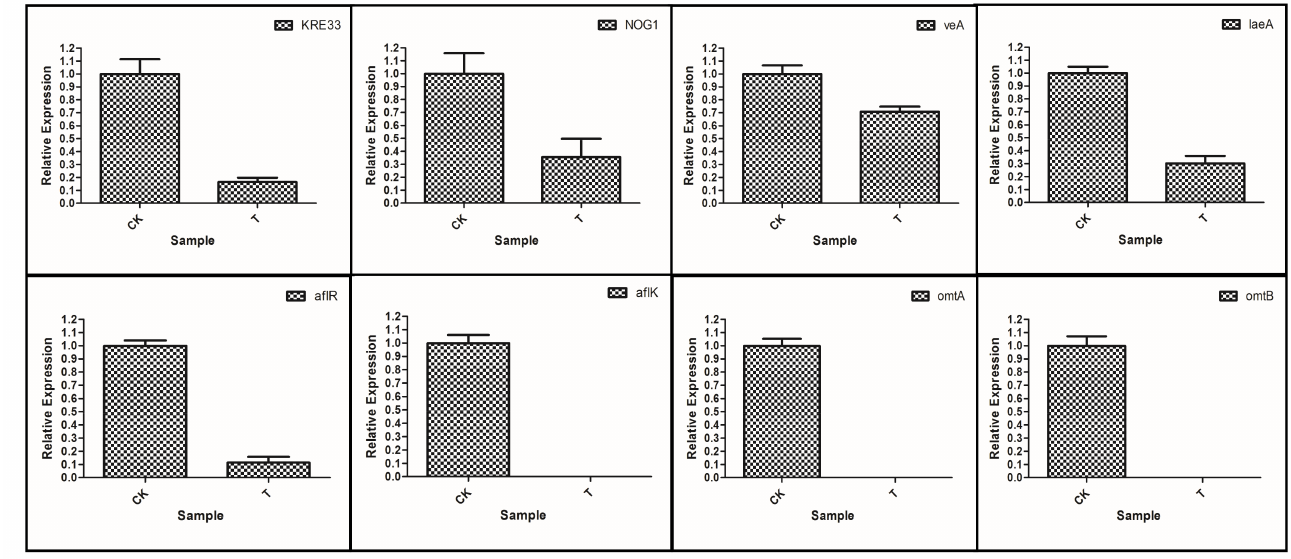
Figure 11. RT-qPCR verification results of some key differential genes. The actin gene was used as a reference gene. Vertical bars represent standard errors of the mean. ( p <